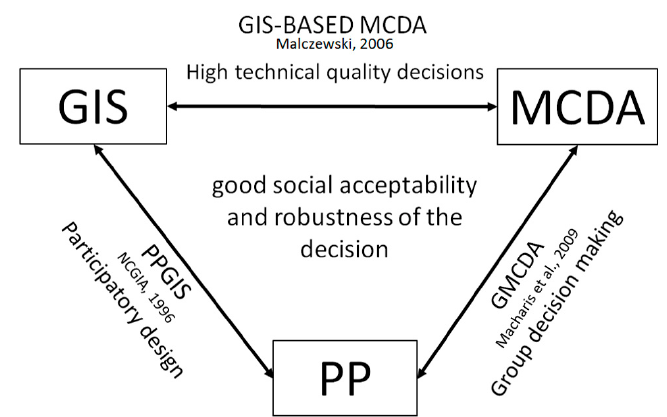
Figure6. TriangleofintegrationofGIS,PublicParticipationandMCDAinthetransportdecision-making Figure 6. Triangle of integration of GIS, Public Participation and MCDA in the transport decision- process (adapted from making process (adapted from[110]).